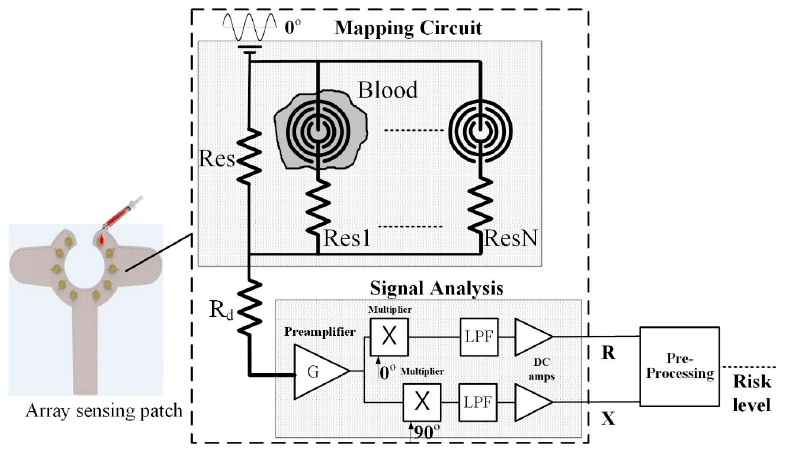
Figure 3 . Mapping circuit and pre-processing schematic diagram [11]. Figure 3. Mapping circuit and pre-processing schematic diagram